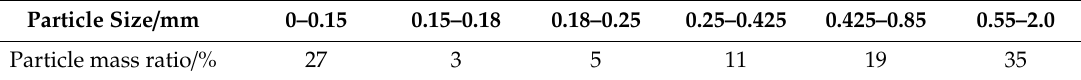
Table 2. Particle size of the briquette coal